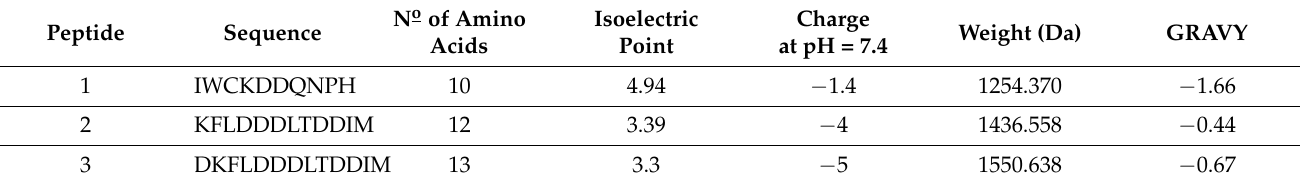
Table 1. General characteristics and physicochemical properties of peptides. Weight, isoelectric point, and charge at physiological pH were assessed with MOE’s QSAR package. GRAVY in- dex was calculated through the GRAVY calculator (http://www.gravy-calculator.de/, accessed